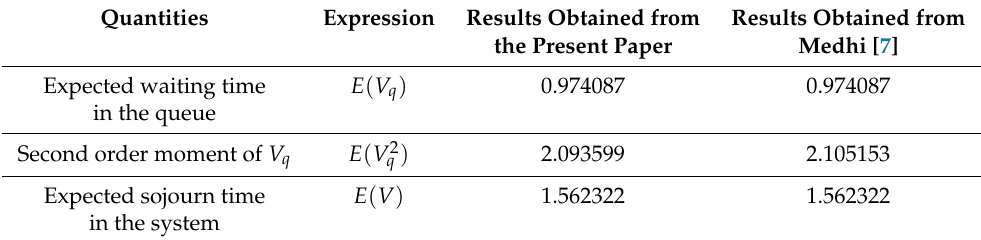
Table 6. Performance measures of different quantities with that of